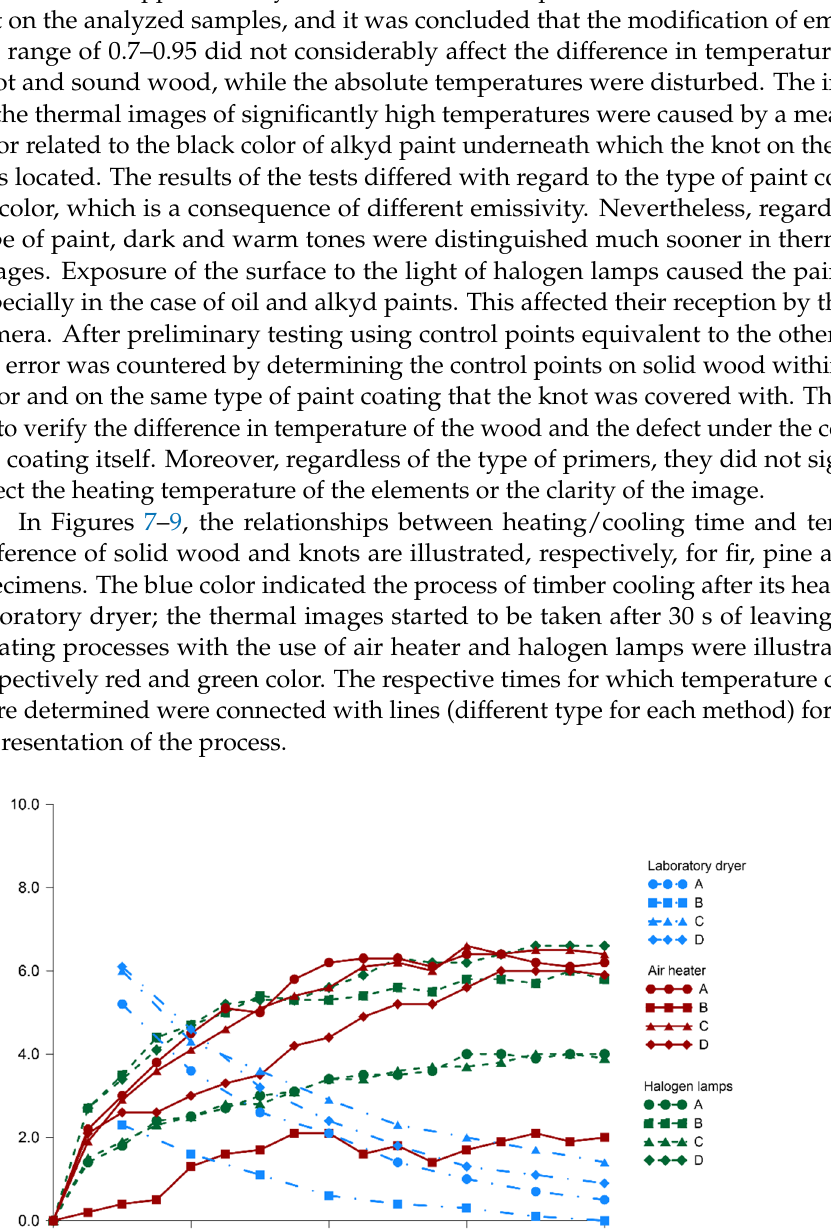
Figure 8. The relationship between heating/cooling time and temperature difference of solid pine wood and knots. Figure 9. The relationship between heating/cooling time and temperature difference of solid spruce wood and knots.